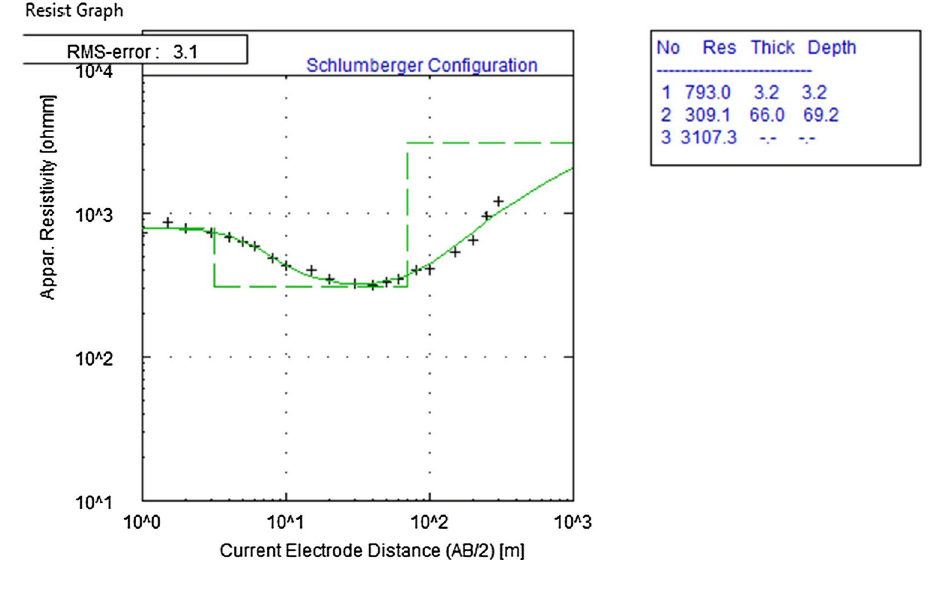
Fig. 6 Typical VES model obtained in the